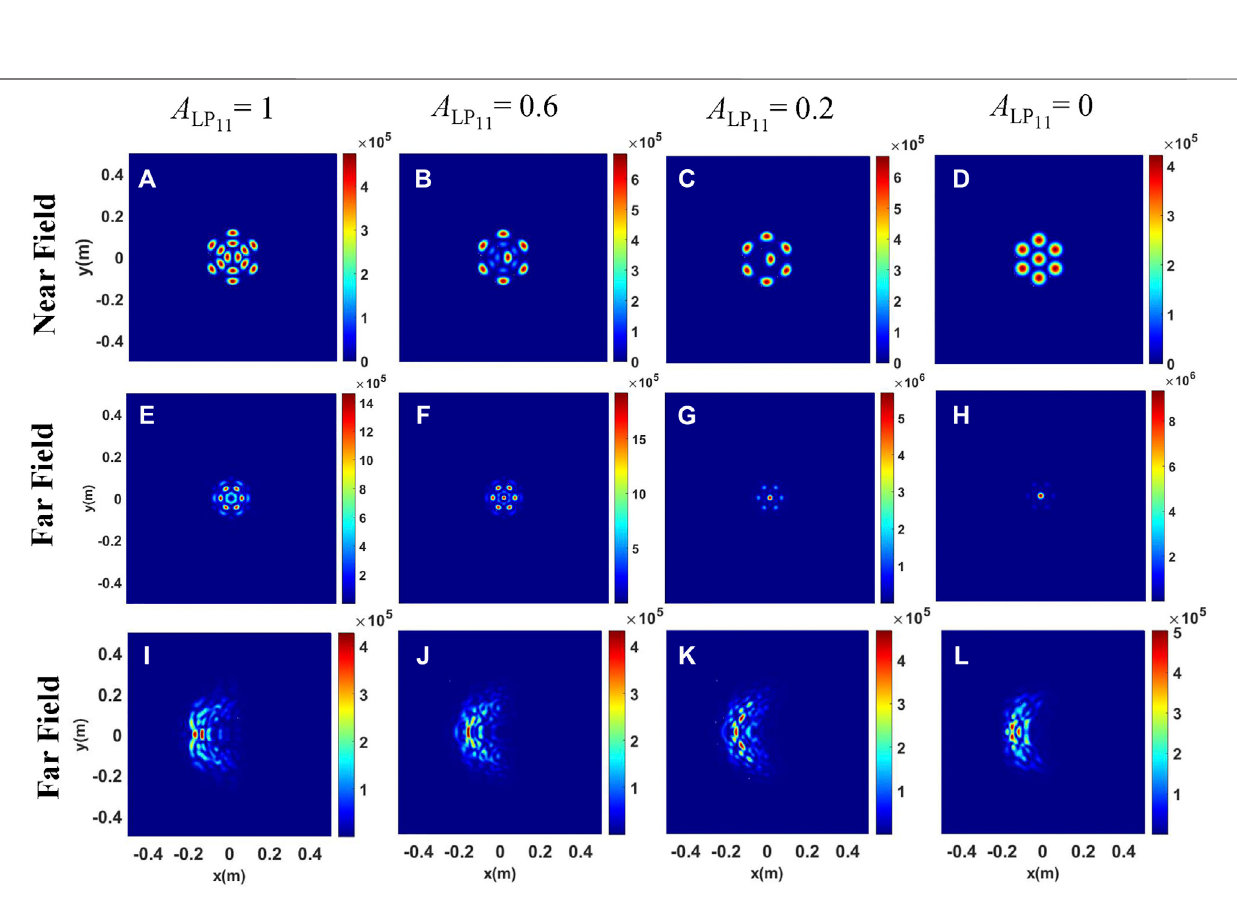
Frontiers in Physics |